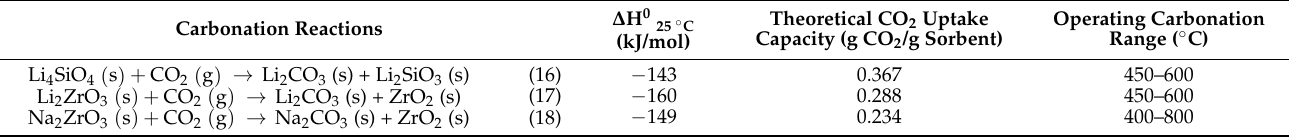
Table 5. Carbonation reactions of alkali sorbents, theoretical CO 2 uptake capacity and operating carbonation temperature range